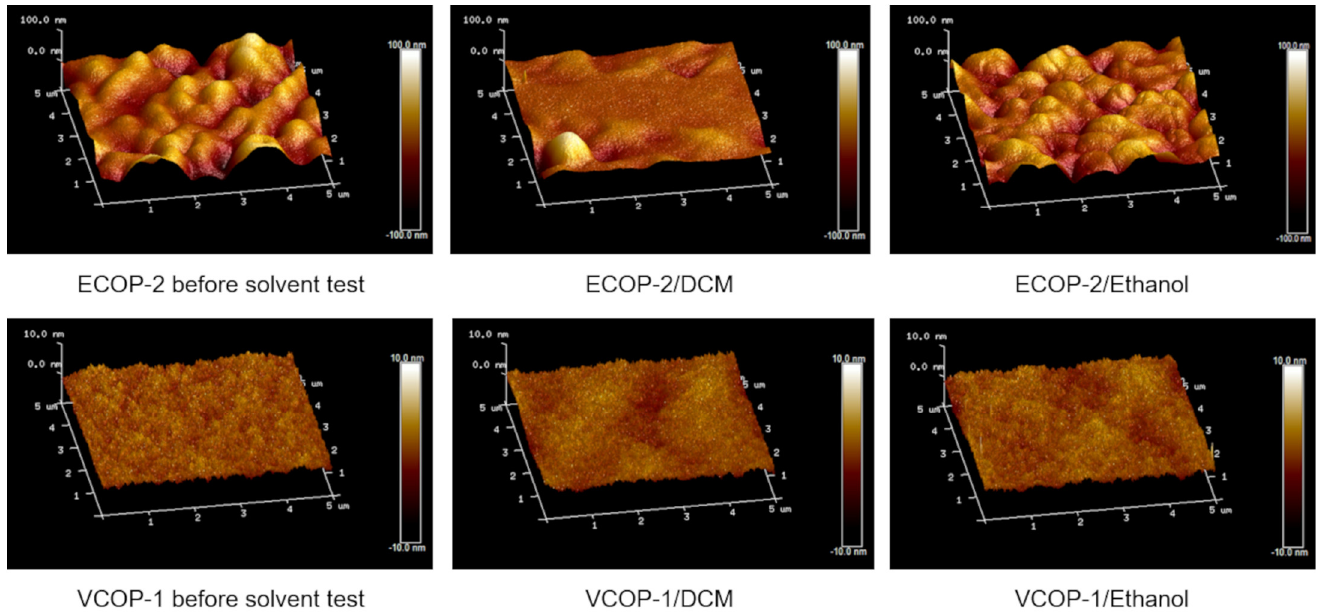
Figure 9. AFM surface analysis of copolymers before and after immersion in DCM and ethanol for 30 min.